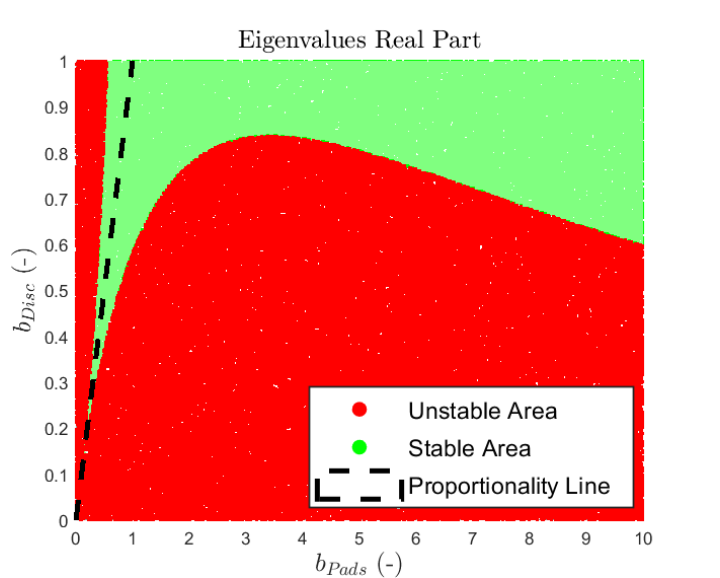
Figure 2. Influence of the damping matrix structure on the stability of the break disc model. The structure of damping matrix is changed by two dimensionless parameters. Red zone—unstable systems, green zone—stable systems, black dashed line—the proportionality line.